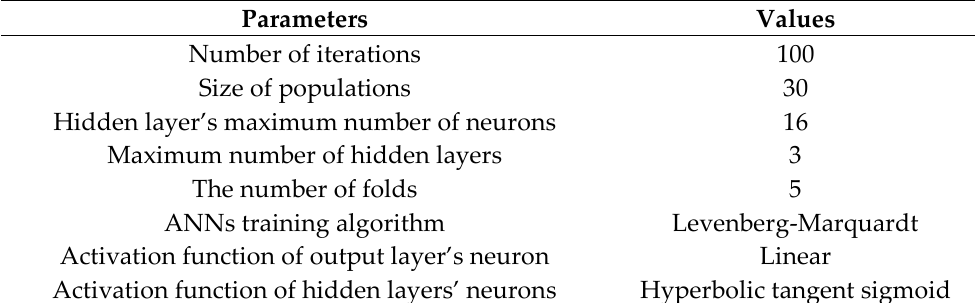
Table 2. Adjustment parameters of modified